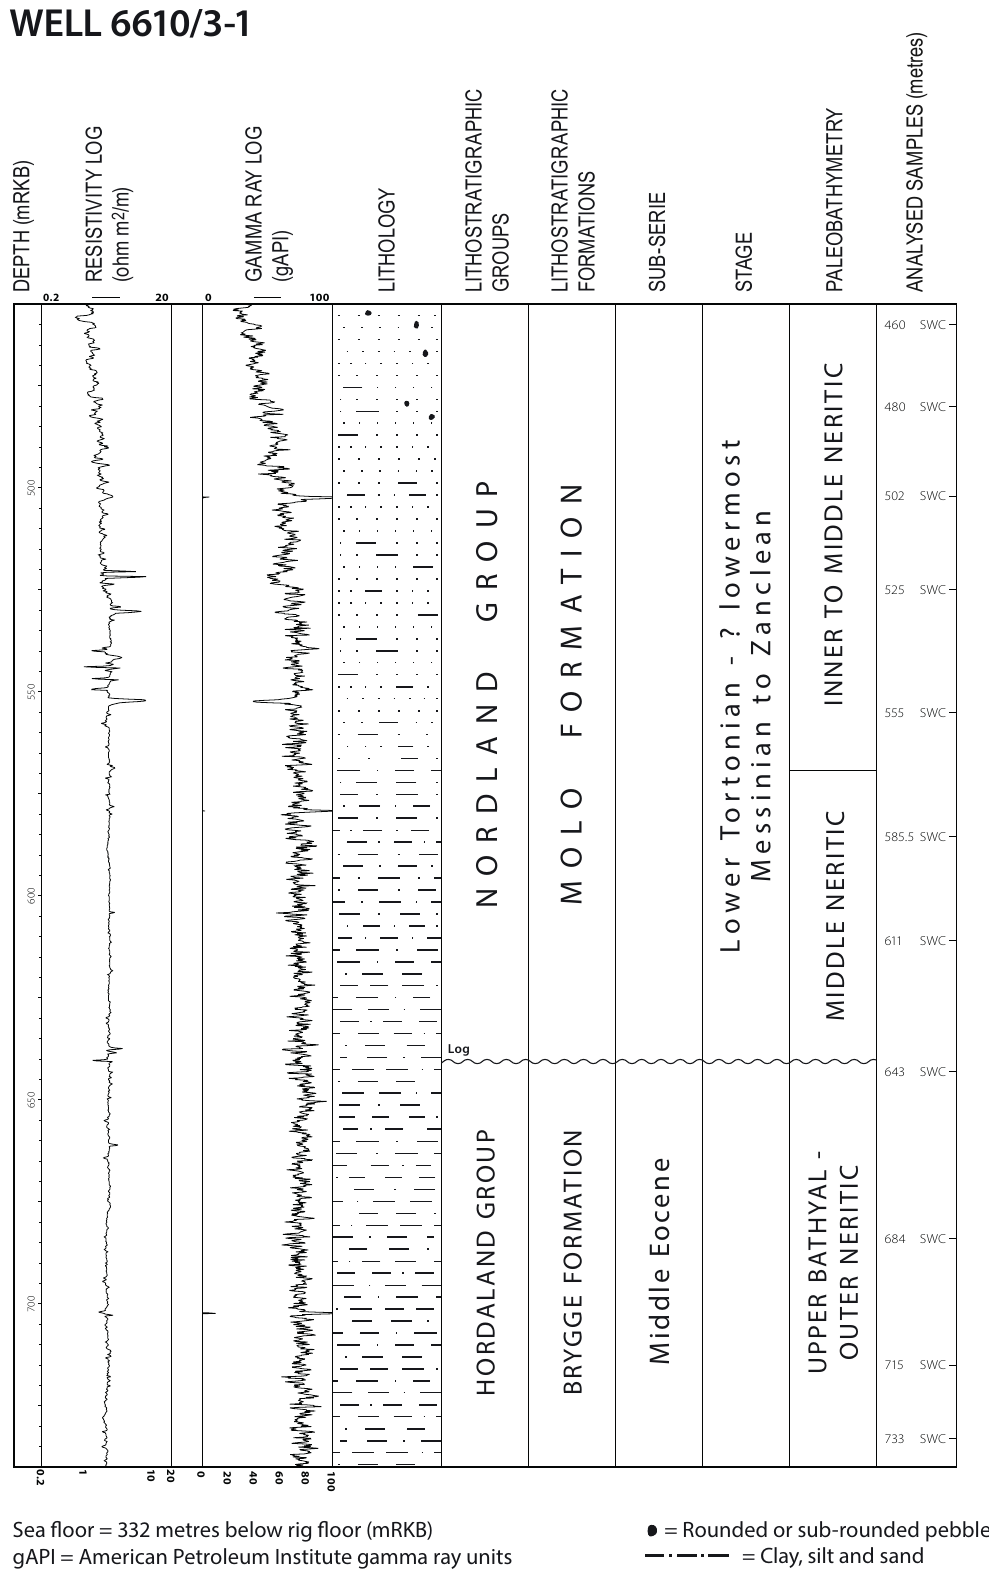
Sea floor = 332 metres below rig floor (mRKB) gAPI = American Petroleum Institute gamma ray units SWC = Side-wall core Figure 72. Well summary figure including resistivity log, gamma-ray log, lithology, lithostratigraphic units, sub-series, stage, paleobathymetry and analysed samples for the investigated sequence in well 6610/3–1 (middle–upper Eocene to upper Tortonian) including the reference well section for the Molo Formation (modified after Eidvin et al., 2007, 2013d; Grøsfjeld et al.,